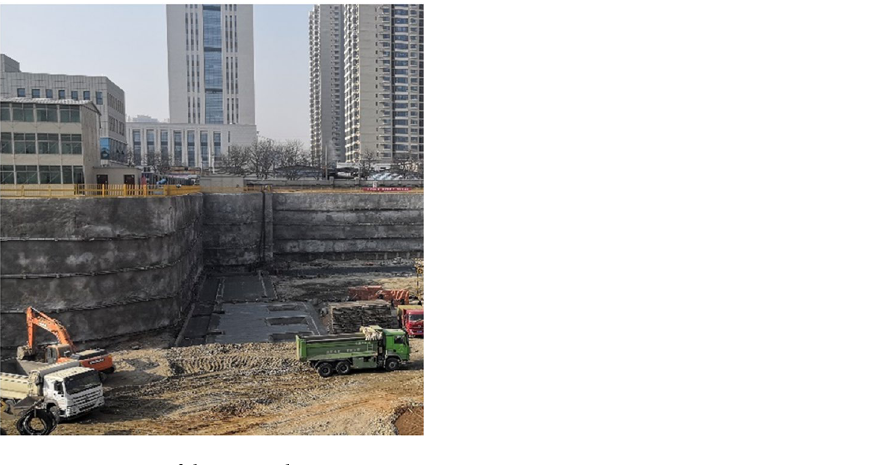
Figure 1. Picture of the external